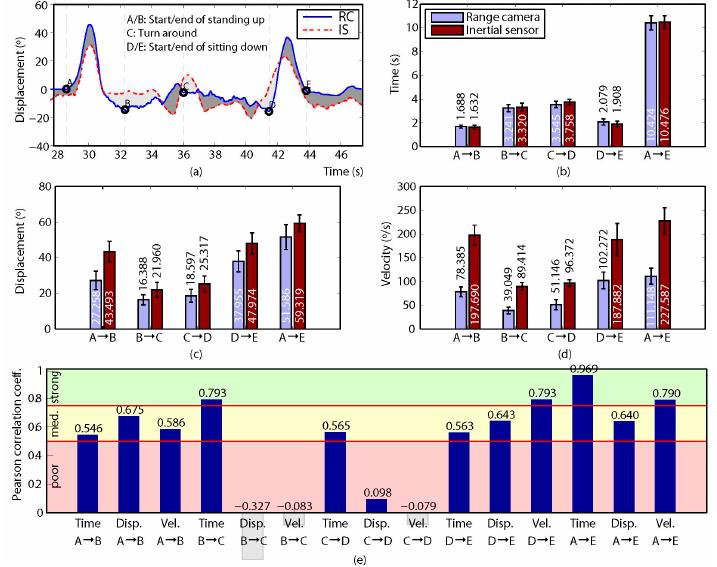
Figure 8. Results for the TUG test. ( a ) Comparison of the measured displacement provided by the depth camera (solid blue) and the inertial sensor (dashed red) for a representative participant. The positions of the defined control points are also shown; ( b – d ) mean time (with CI 95%), mean angular displacement (with CI 95%) and mean angular velocity (with CI 95%), respectively, over all the participants for the intervals defined by the control points; ( e ) Pearson Correlation Coefficient (r) (p < 0.005) between the devices for all the measured variables. (Time is expressed in seconds, angular displacement in degrees, and angular velocity in degrees per second).